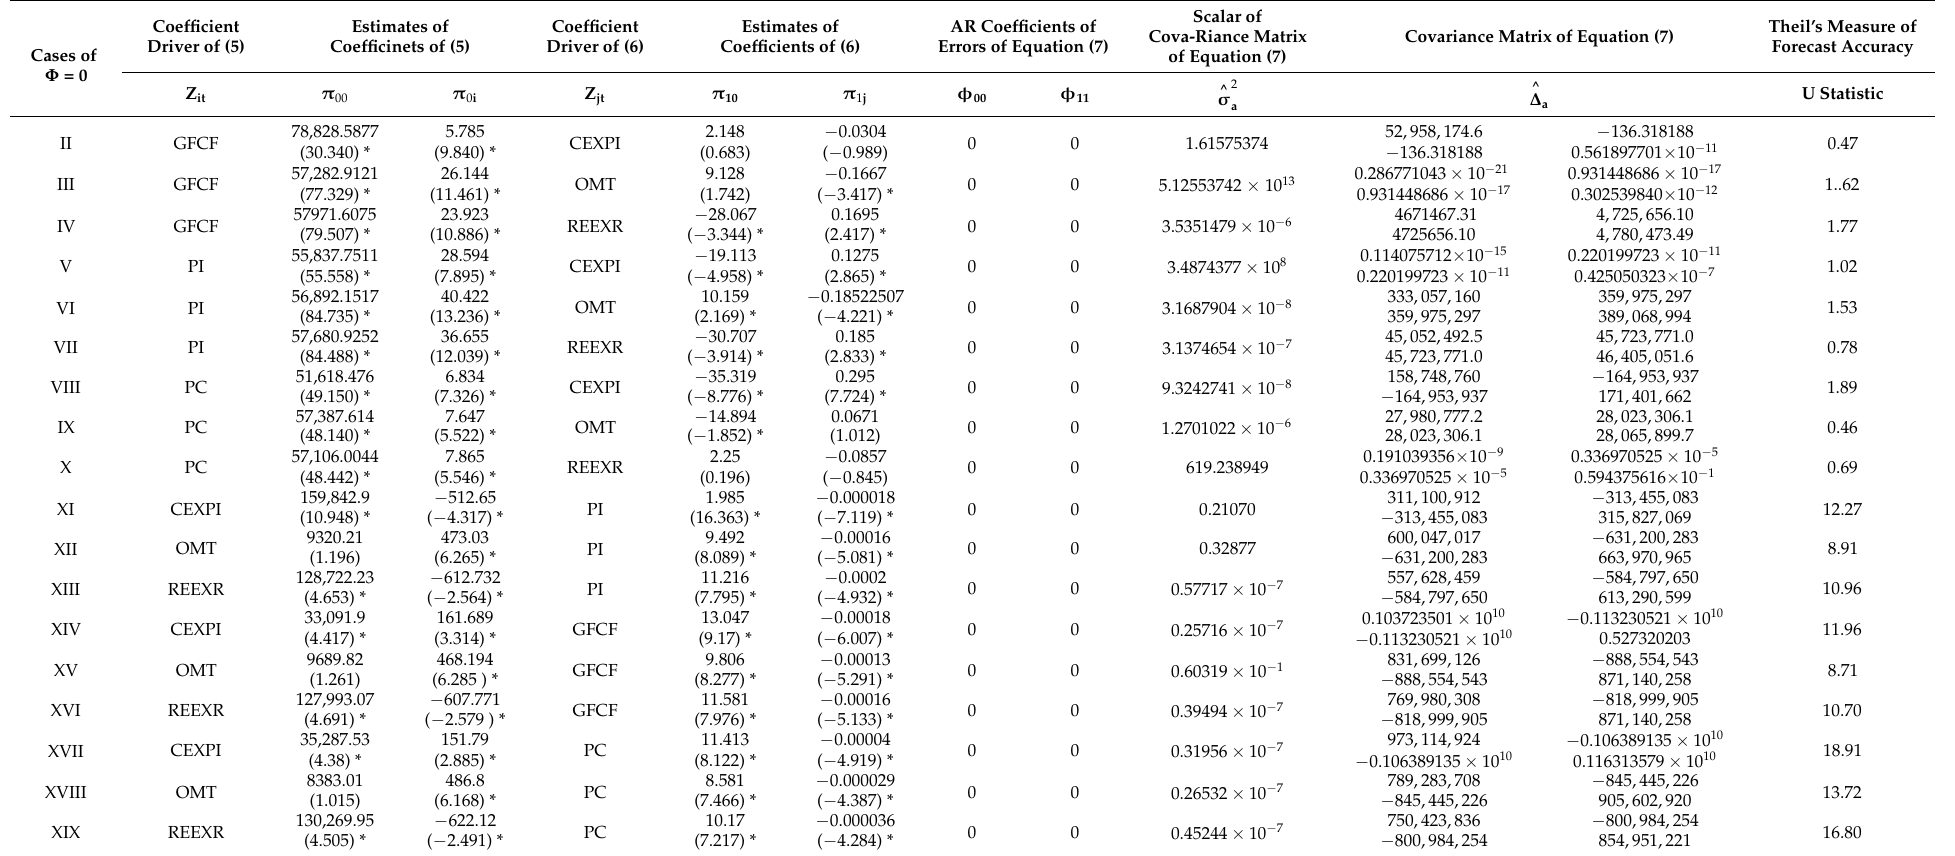
Table 1. Estimates of the Coefficients of Equations (5) and (6) and the Variance-Covariance of Process (7) When the Diagonal Parameter Matrix Φ of Process (7) is Restricted to be Zero